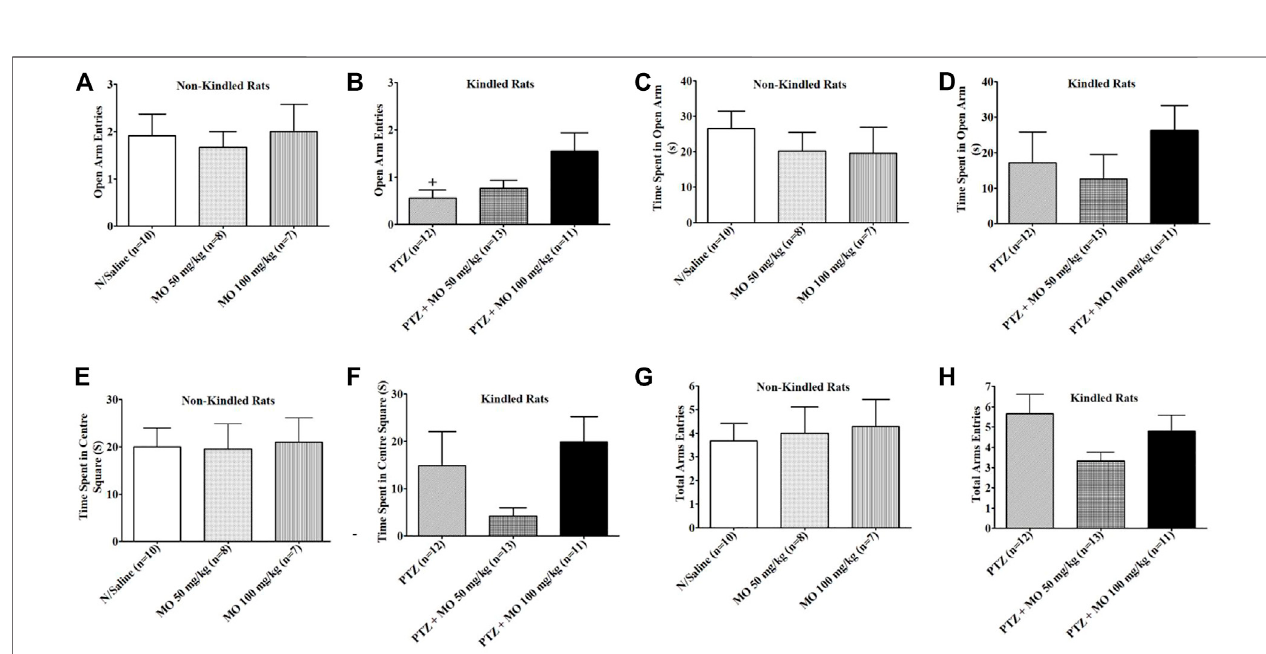
FIGURE 6| Effects of Melissa of fi cinalis L. essential oil (MO) on performanceof pentylenetetrazole (PTZ)-kindled rats on elevated plus maze. (A) Opened arm entry innon-kindledrats; (B) Openedarmentryinkindledrats+ p < 0.05(N/SalinevsPTZ); (C) Timespentinopenedarmbynon-kindledrats; (D) Timespentinopenedarmby kindled rats; (E) Time spent in centre square in non-kindled rats; (F) Time spent in centre square in non-kindled rats; (G) Total arm entries by non-kindled rats; (H) Total arm entries by kindled rats. n (cid:2) number of animals tested. Mean ± SEM.